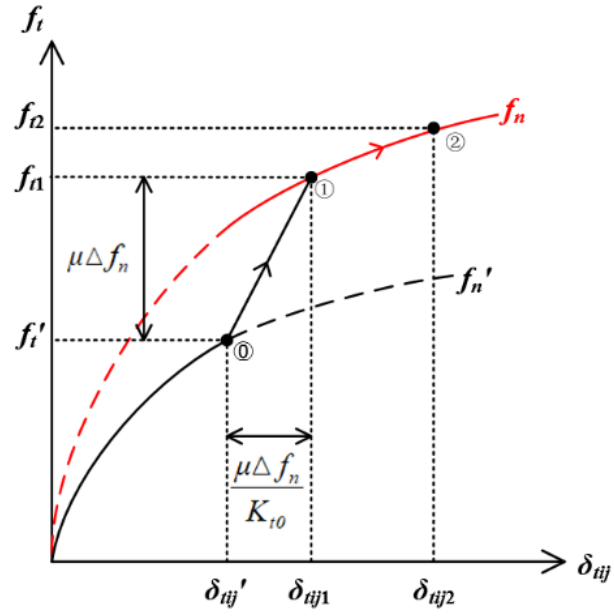
Figure 1. Process of the complete MD model when the displacements increase.